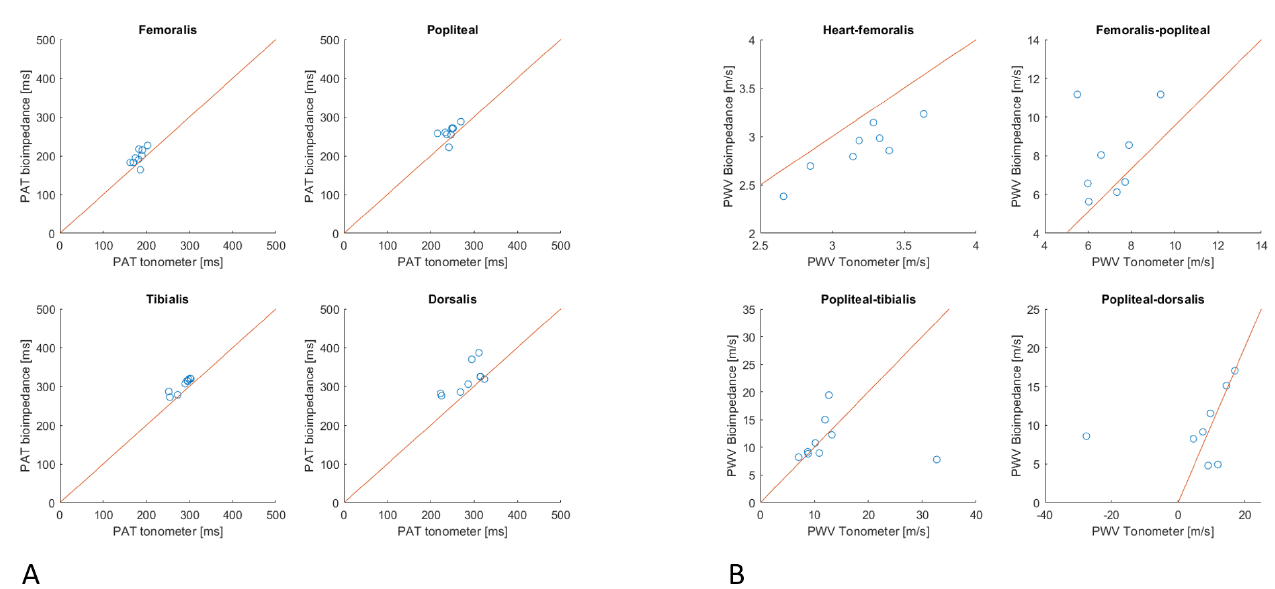
Figure 4: The relation between bioimpedance and tonometer measurements plotted along an x=y line in the a. femoralis, a. popliteal, a. tibialis posterior and a. dorsalis pedis using the mode from the nine healthy participants for (A) the estimated pulse arrival time (PAT) in milliseconds and (B) the calculated pulse wave velocity (PWV) in meters per second based on the PAT modes and measured distances between the